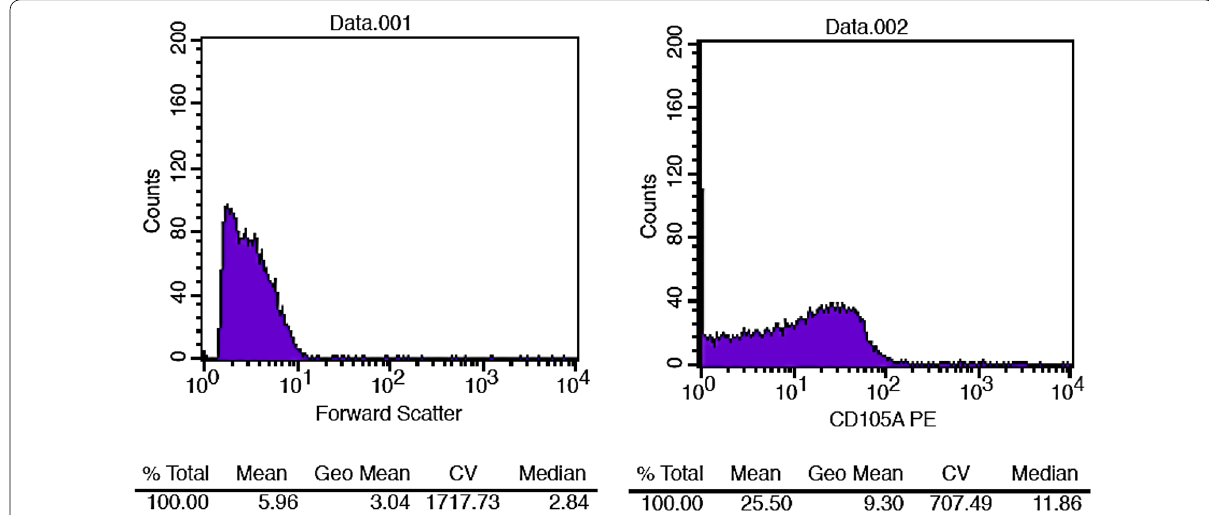
Fig. 8 Single parameter histogram to evaluate the relative expression of a marker, in this case, the shift of the histogram peak for CD105 PE allows easy identification of the CD 105 positive cells indicates stem cell character